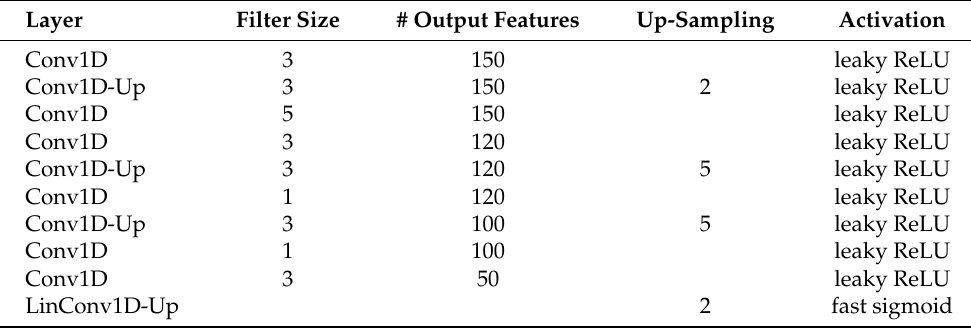
Table A2. Layers of the F 0-Net. For layer type notation see Section 2.1.